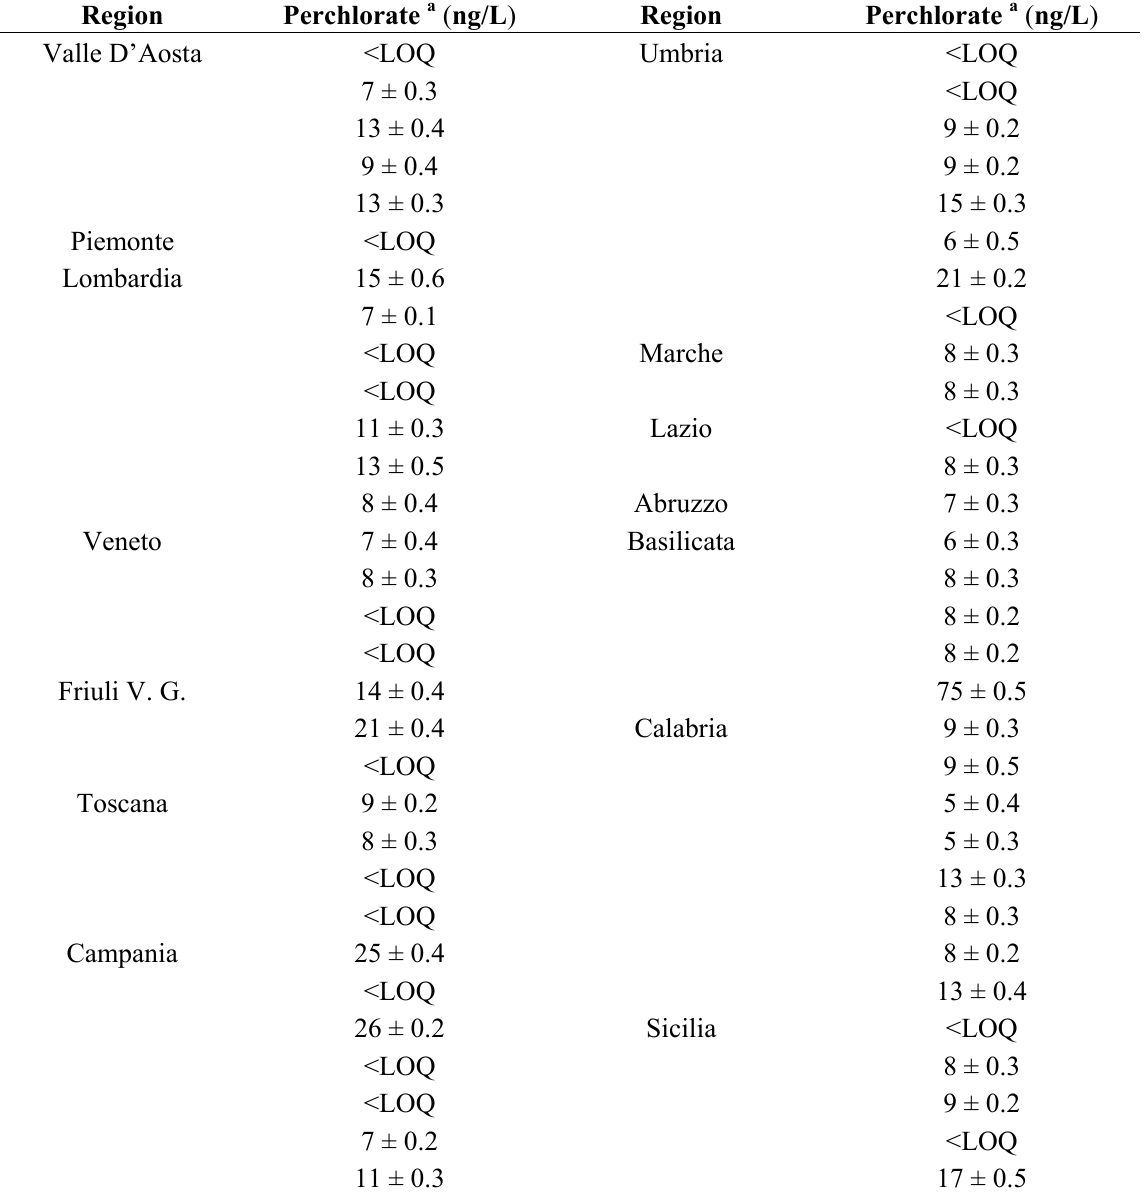
Table 1. Perchlorate concentration in bottled water from different Italian